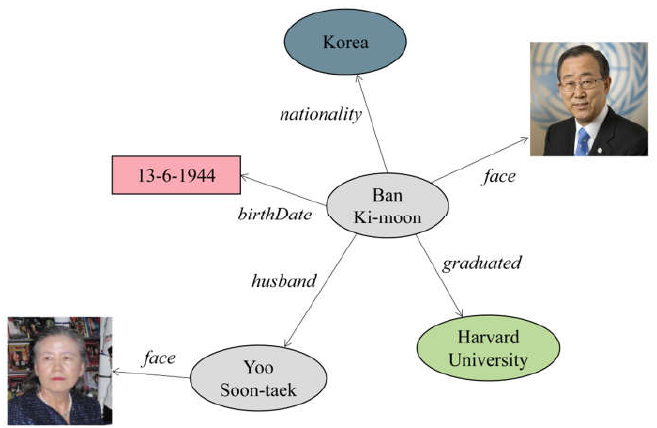
Figure 1. An example of a multimodal person relation graph.